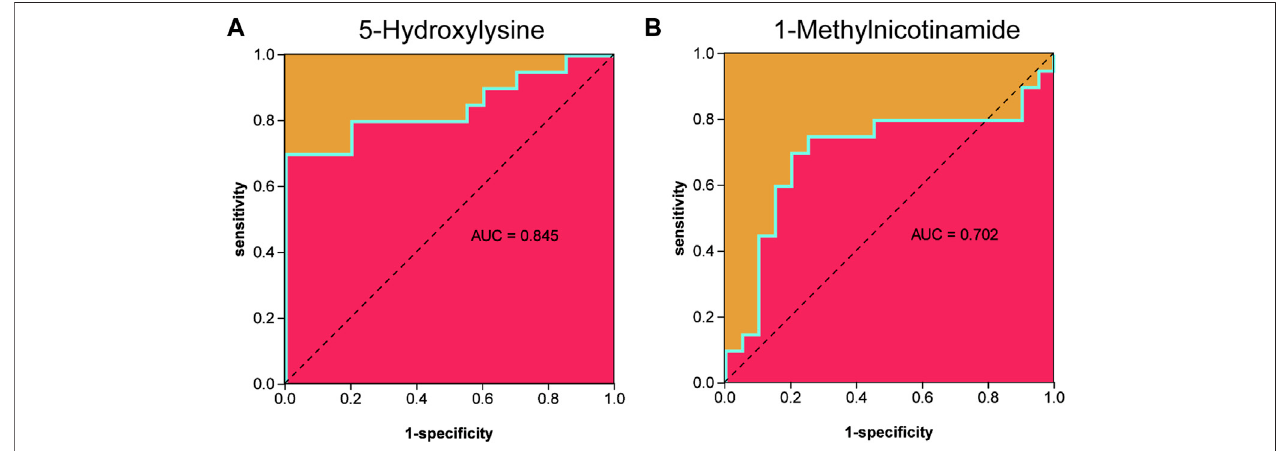
FIGURE 9 | (A) Receiver operator characteristic curve indicated that the expression level of 5-hydroxylysine could sensitively and speci fi cally predict keloids. (B) The receiver operator characteristic curve indicated that the expression level of 1-methylnicotinamide could sensitively and speci fi cally predict keloids.